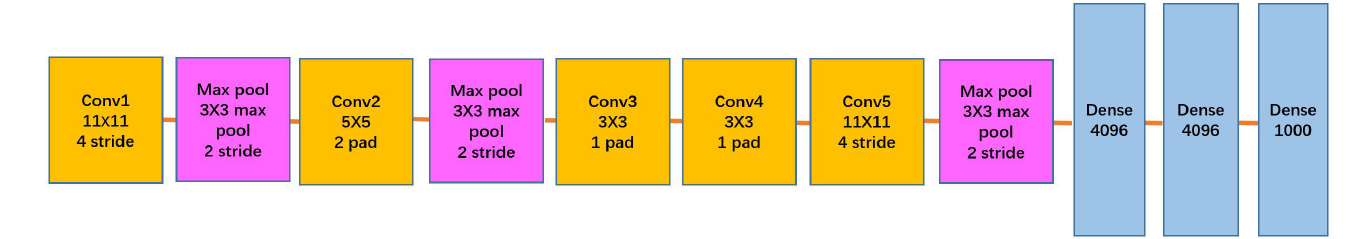
Figure 10. Architecture of AlexNet with convolutional layers (orange), max pooling layers (pink), and fully connected layers (blue).